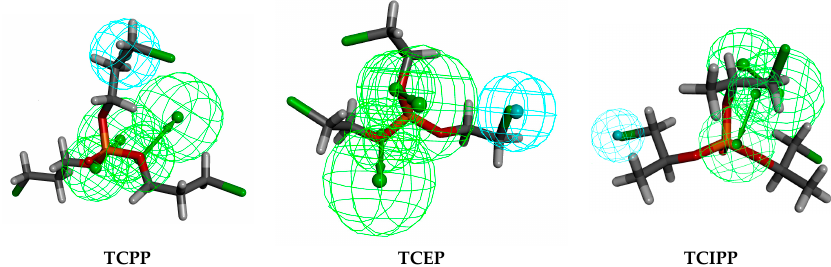
Figure 1. Three-dimensional congruent map of Hypo C1 and TCPP, TCEP and TCIPP.